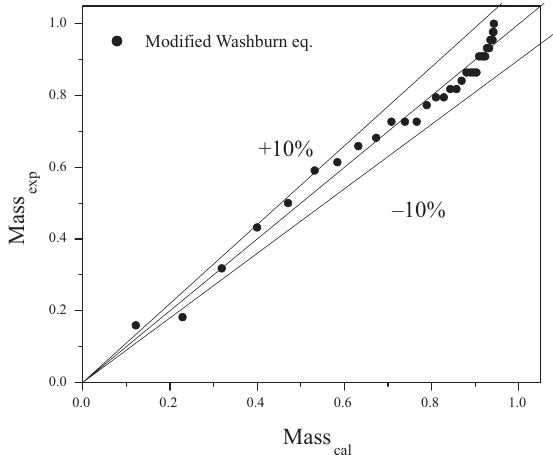
Fig. 13. Correlation between experimental values (mass and calculated (mass ) by means of the modified Washburn cal equation for the oil imbibition process